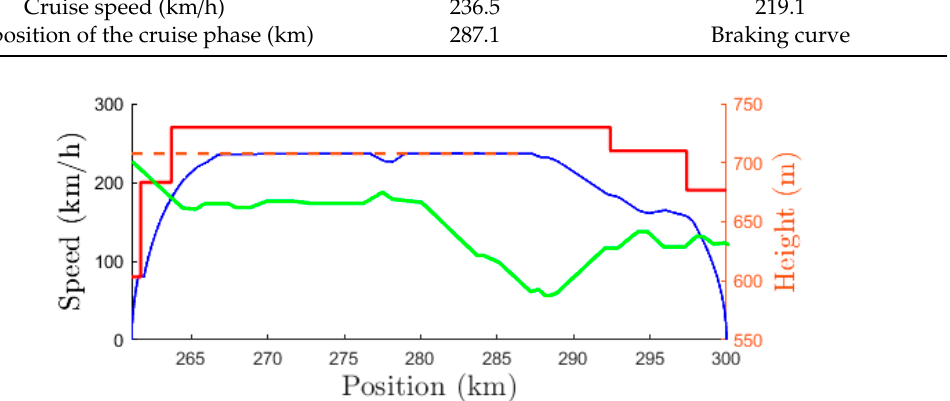
Figure 14. Eco-driving speed profile for the commercial time in the Puertollano–Ciudad Real line section.